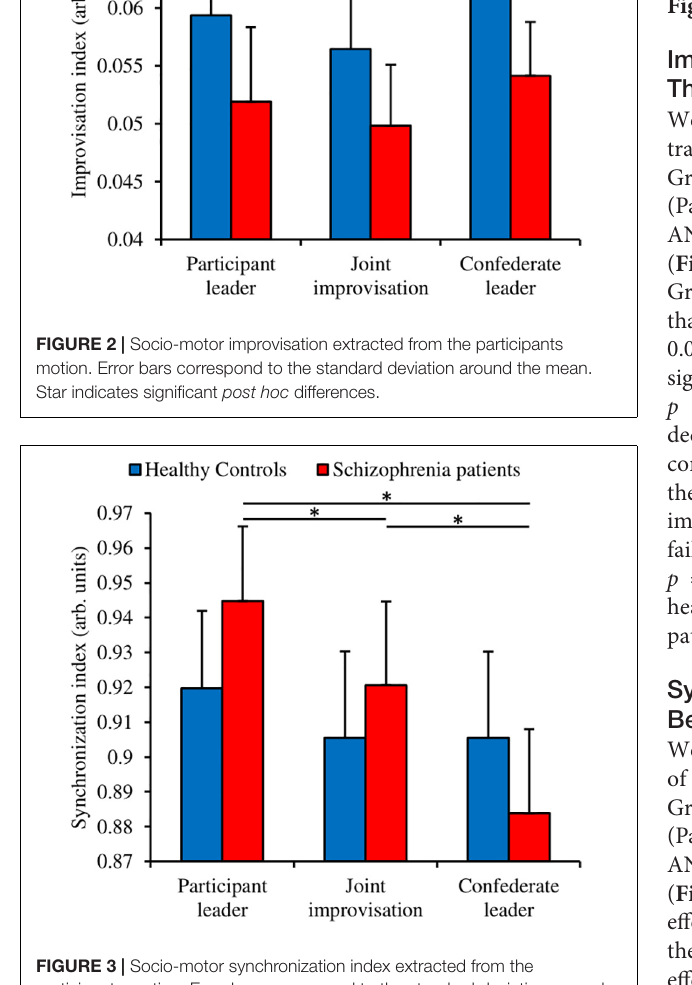
FIGURE 3 | Socio-motor synchronization index extracted from the participants motion. Error bars correspond to the standard deviation around the mean. Star indicates significant post hoc